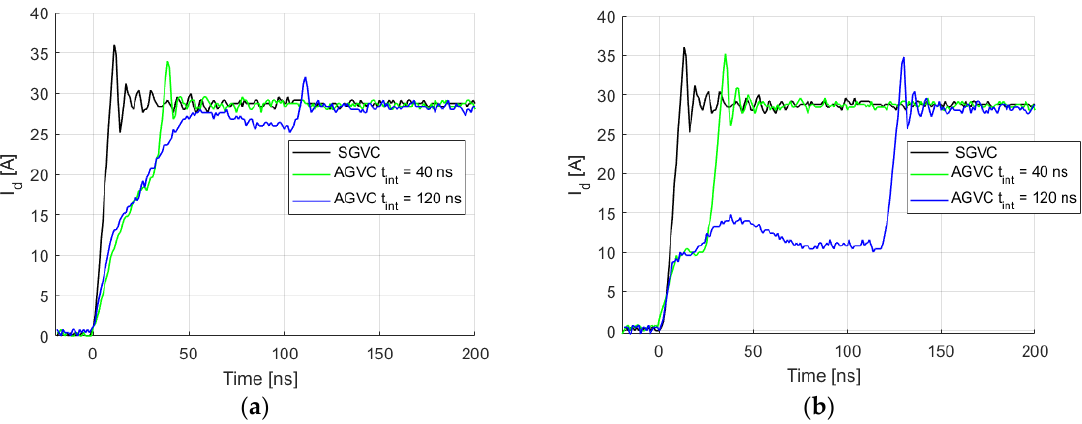
Figure 7. Current waveforms during turn-on using AGVC for different load current values and different tint values. ( a ) V grint = 4 V, ( b ) V grint = 3.5 V.